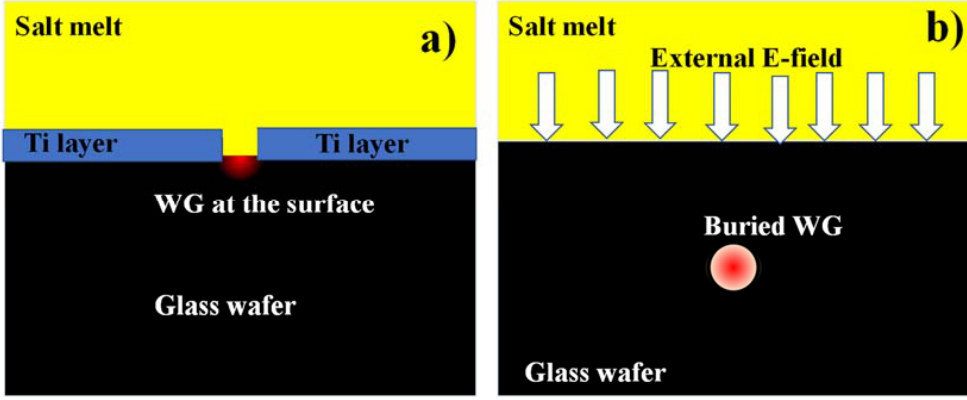
Figure 5. ( a ) Thermal ion-exchange produces a D-shaped surface WG, ( b ) Electric-field assisted buried WG. buried